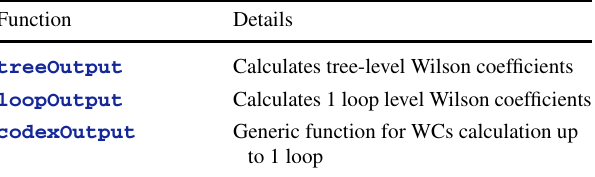
Table 4 Available functions for calculating Wilson coefficients (WCs) for a given BSM